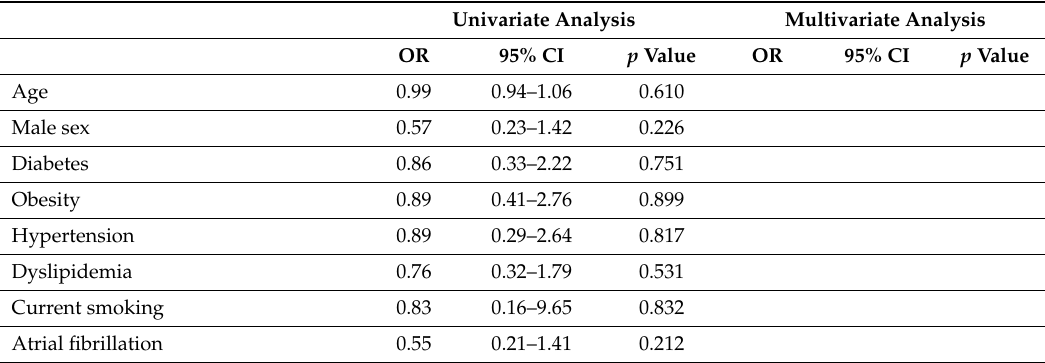
Figure 2. Kaplan–Meier plots of COVID-19-free survival (panel A), COVID-19-related mortality (panel B), and severe-COVID-19-free survival (panel C) according to the ABO blood group (group A versus other groups). Table 3. Factors associated with the occurrence of COVID-19 in patients who had undergone transcatheter aortic valve replacement.